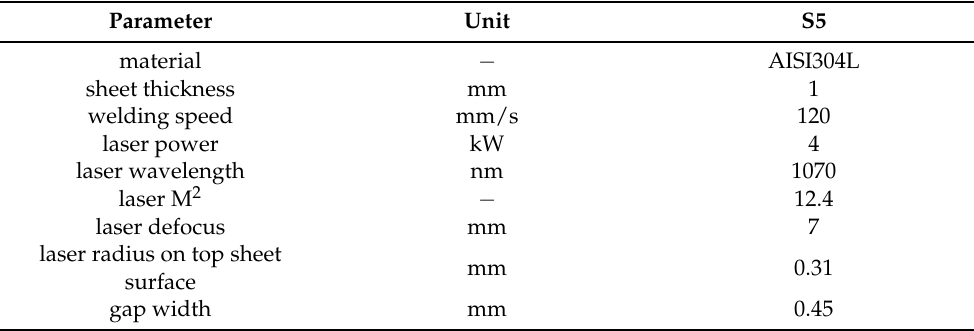
Table 4. Conditions of the LBW simulation S5 used for the investigation of the pore formation mechanism. Parameter Unit S5 material −